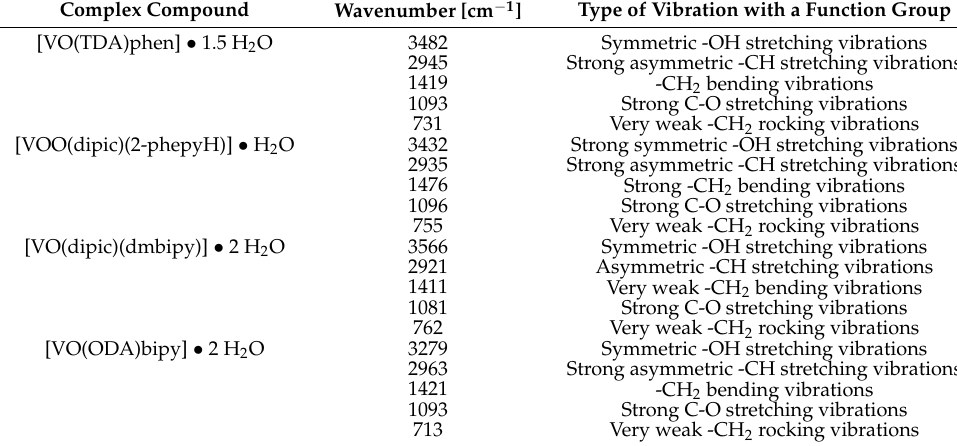
Table 3. The results of FTIR spectroscopy for the products of 2,3-dibromo-2-propen-1-ol